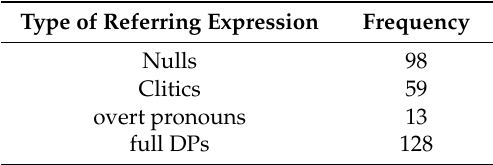
Table 4. Raw frequencies of nulls, clitics, overt pronouns, and full noun phrases (DPs) occurring in the